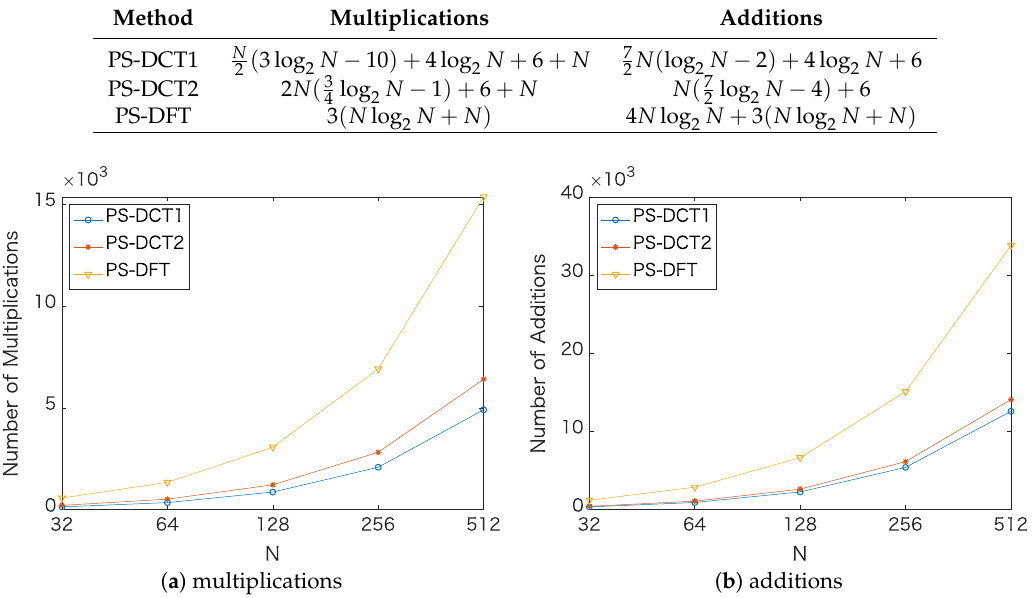
Table 4. Arithmetic operations for PS-DCT1, PS-DCT2, and PS-DFT in real numbers.